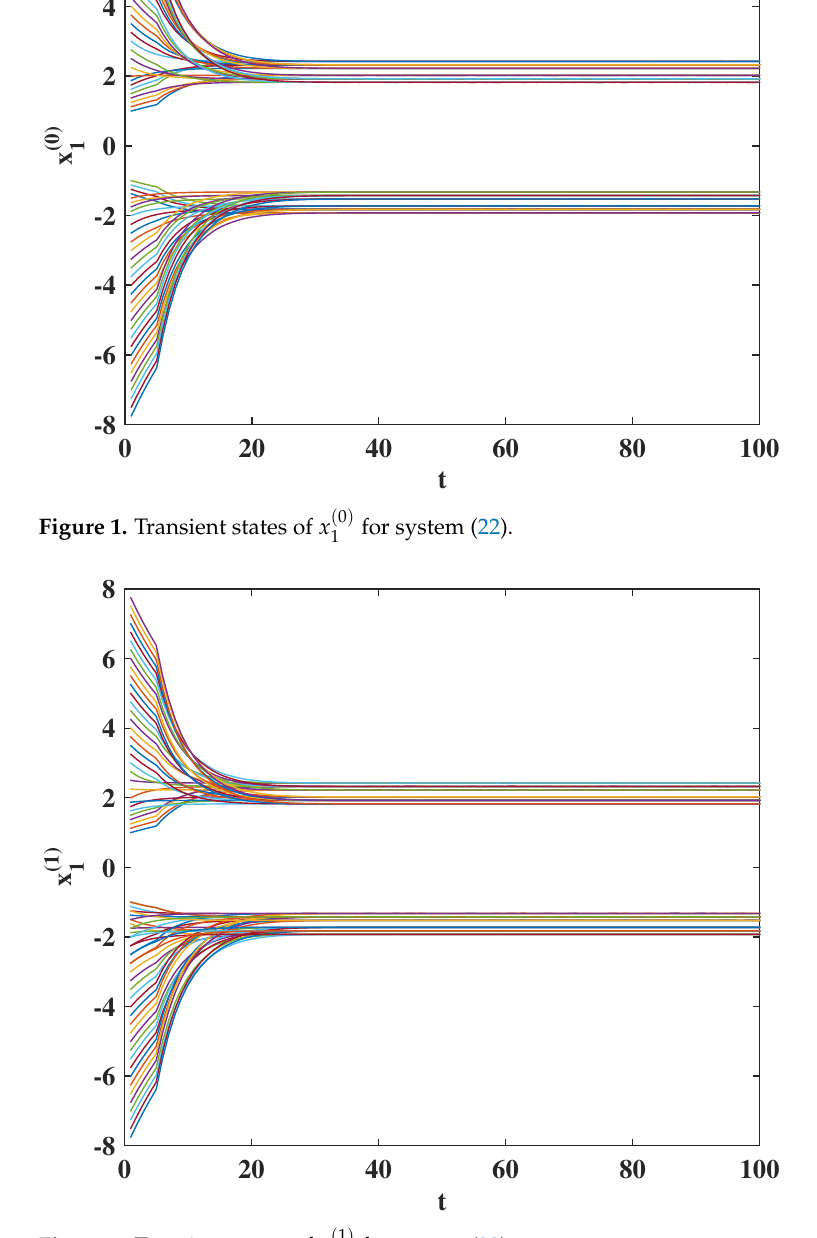
Figure 2. Transient states of x